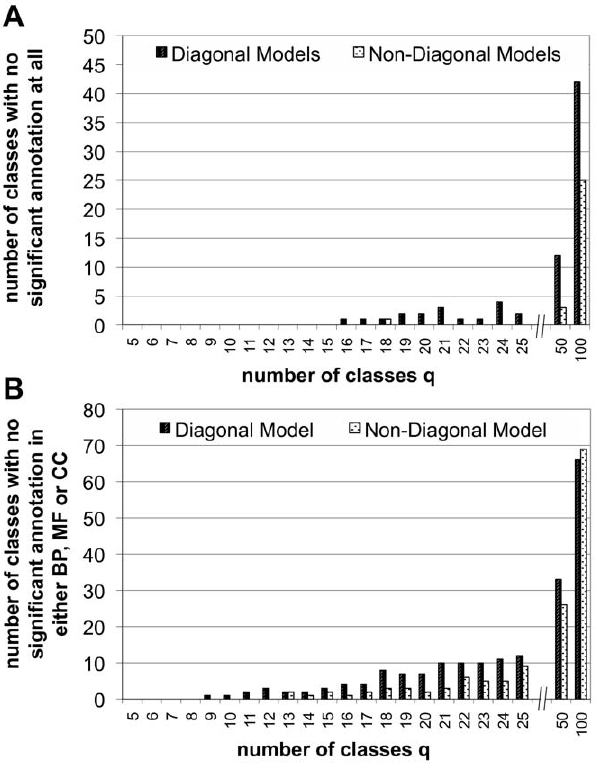
Figure 4. Number of classes not enriched in GO-terms with high significance. A Number of classes not significantly enriched below the 1% level after Bonferroni-correction in any of the GO categories biological process, molecular function or cellular compartment. B Number of classes not significantly enriched below the 1% level after Bonferroni correction in at least one the GO categories biological process (BP), molecular function (MF) or cellular compartment (CC). Note the different scales. Clearly, the non-diagonal models consistently produce a lower number of classes which are not enriched in functional annotation. This can be seen as an indication that the non-diagonal models not only represent the network better, but the inferred groups also correspond better to known